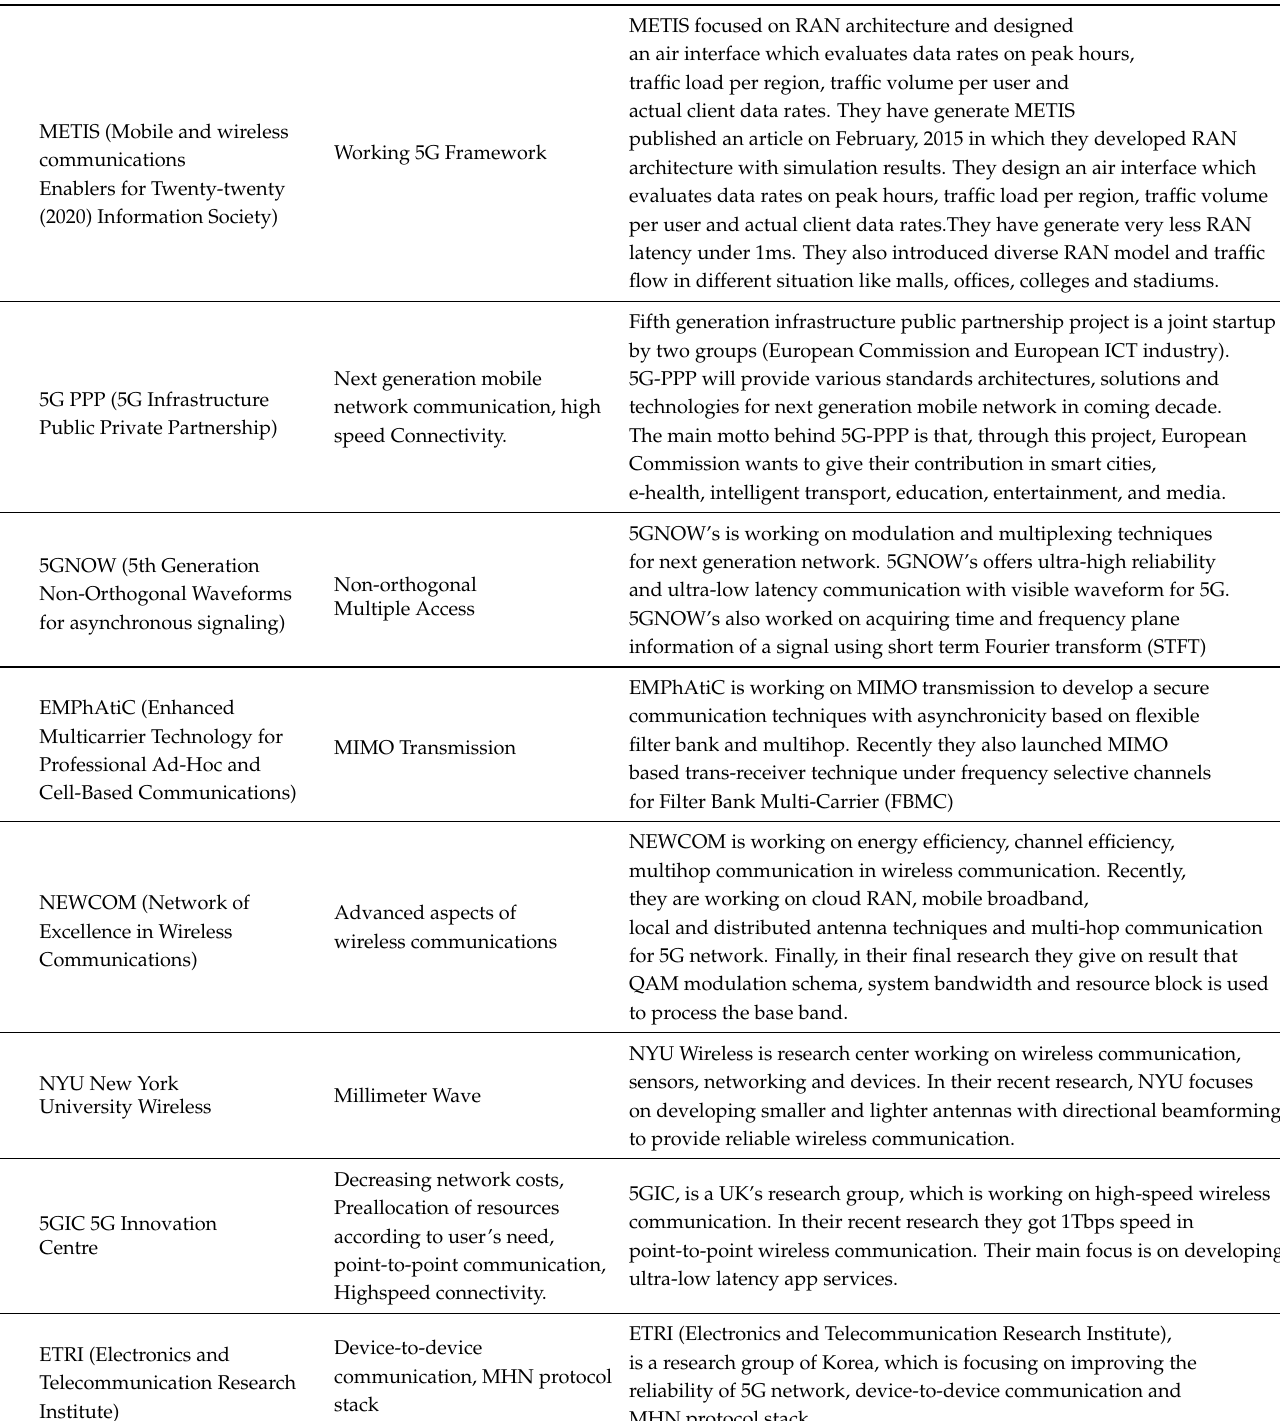
Table 4. Research groups working on 5G mobile